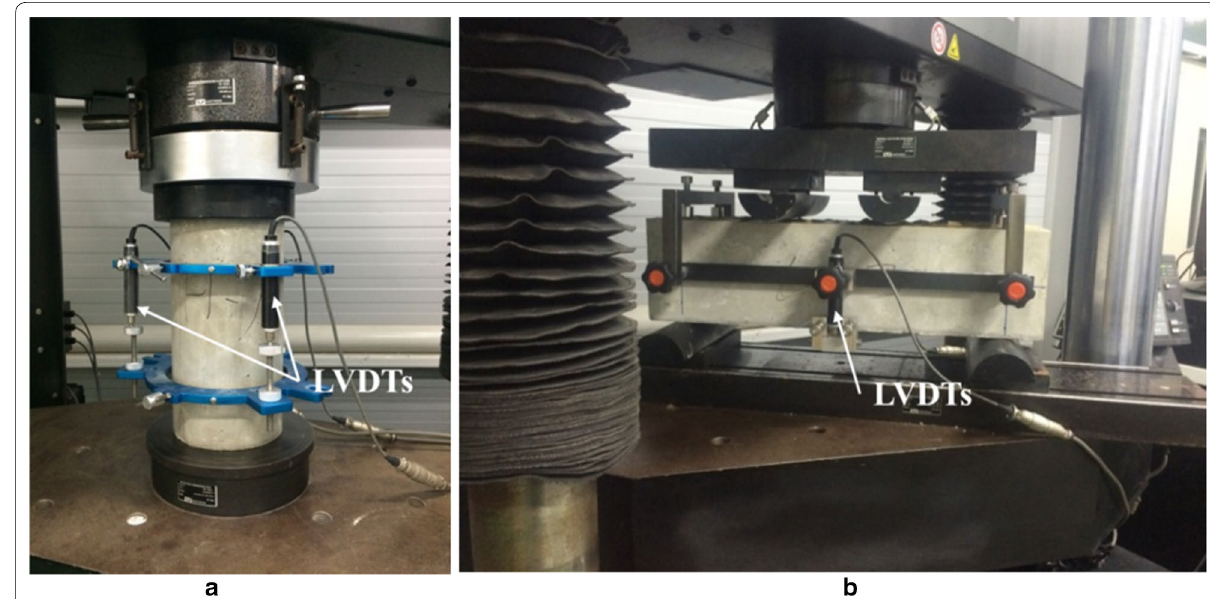
Fig. 11 Test setups: a compression test, and b third-point flexure test.